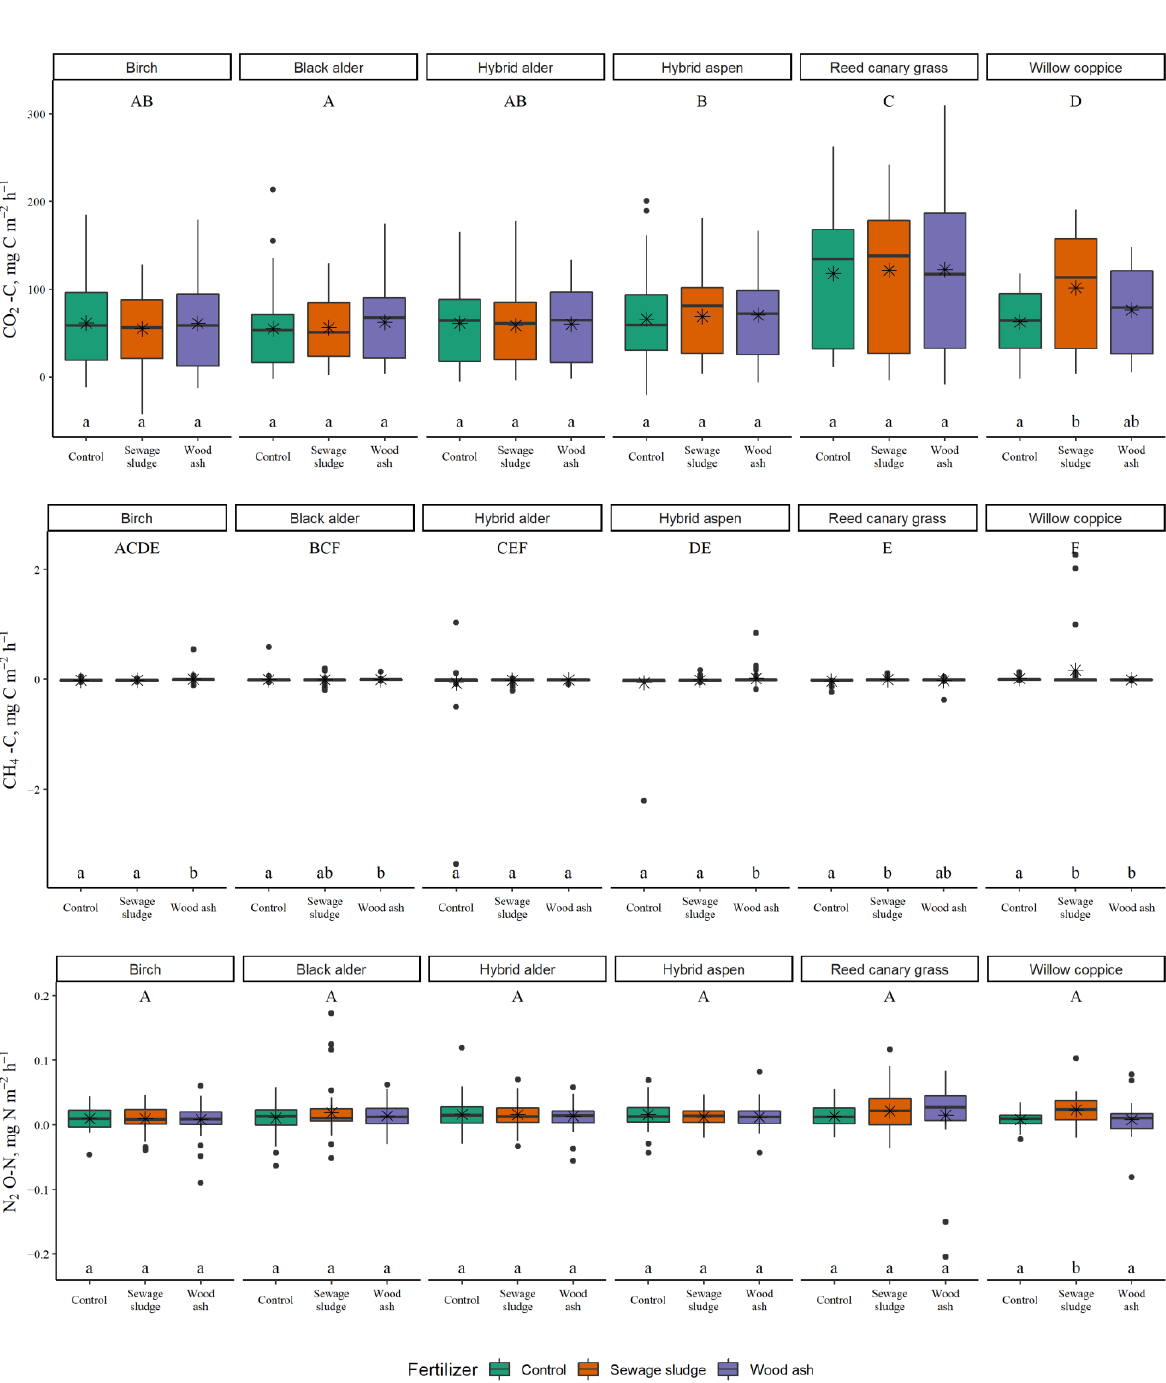
Figure 2. Soil GHG fluxes in plots dominated by deciduous trees, willow coppice or RCG in agro- forestry systems in hemiboreal Latvia during the measurement period (June 2020–October 2021), grouped by type of soil fertilisation practice. In the box plots, the median is shown by the bold line, the mean is shown by the black asterisk, the box corresponds to the lower and upper quartiles, the whiskers show the minimal and maximal values (within 150% of the interquartile range from the median) and the black dots represent outliers of the datasets. Different uppercase letters show sta- tistically significant differences ( p < 0.05) between types of dominant vegetation (all soil fertilisation management practices were pooled); different lowercase letters show statistically significant differ- ences ( p < 0.05) between soil fertilisation management practices within the same dominant vegeta- tion.